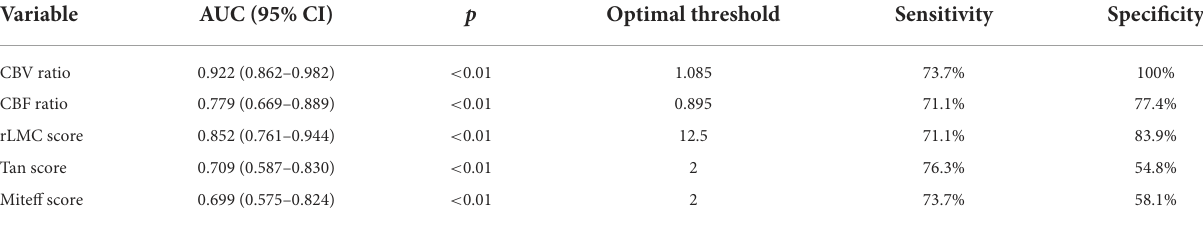
TABLE 3 The area under curve, sensitivity, specificity, and optimal threshold of CTP predictors and qualitative assessments of CS. Variable AUC (95% CI) p Optimal threshold Sensitivity